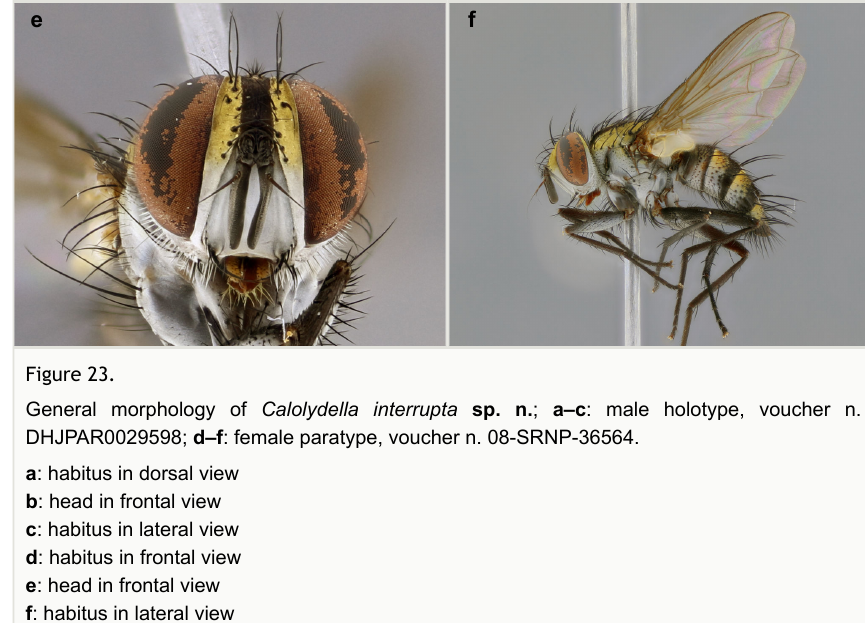
Female (Fig. 23d, e, f). Length: 6mm. Fronto-orbital plate 2X as wide as in male. Diagnosis Calolydella interrupta can be distinguished from all other species of Calolydella by the following combination of traits: parafacial at least 50% silver pollinose, two bold